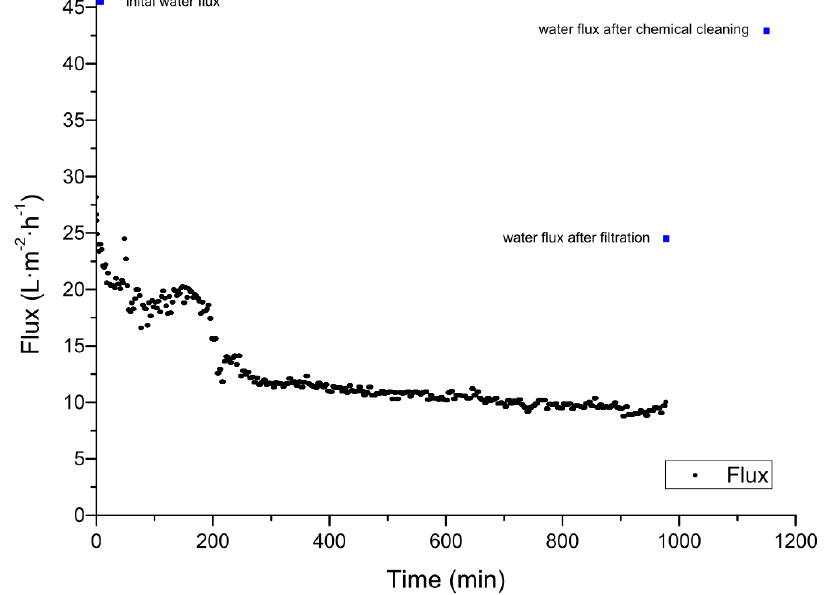
Figure 2. Filtration of spent sulfite liquor using a 5 kDa ceramic membrane at 60 °C, with an average transmembrane pressure (TMP) of 0.4 bar. The blue dots represent the initial pure water flux, the water flux after the filtration, and the water flux after the chemical cleaning. Table 5. Water fluxes at different TMPs before the filtration of spent sulfite liquor, after filtration, and after chemical cleaning.